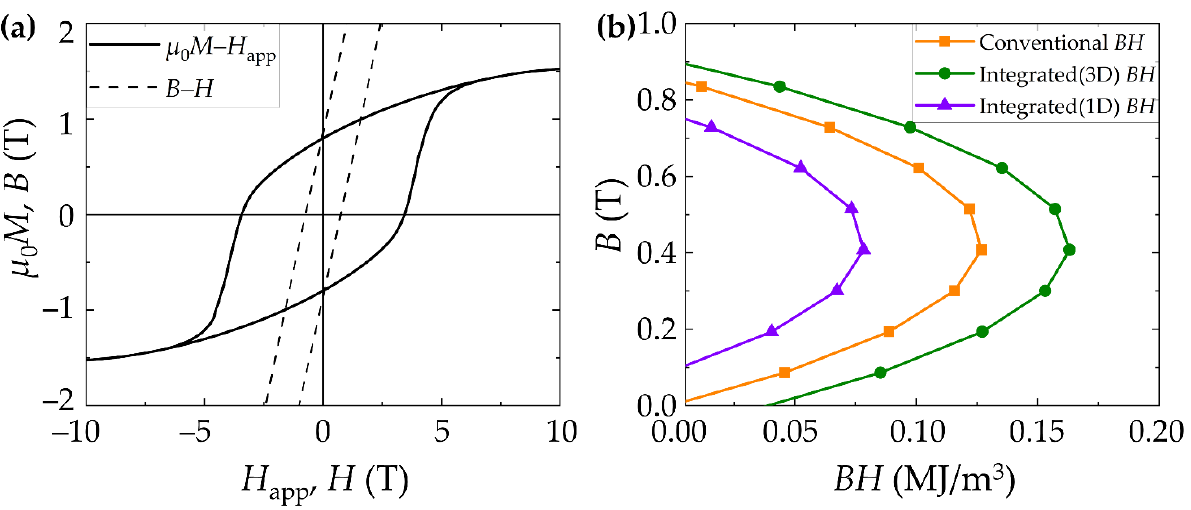
Figure 2. ( a ) Hysteresis loops of magnetization µ 0 M with the applied magnetic field H app , and the magnetic flux density B versus the magnetic field strength H (= H app + H d ). ( b ) Energy product BH calculated in three different ways.